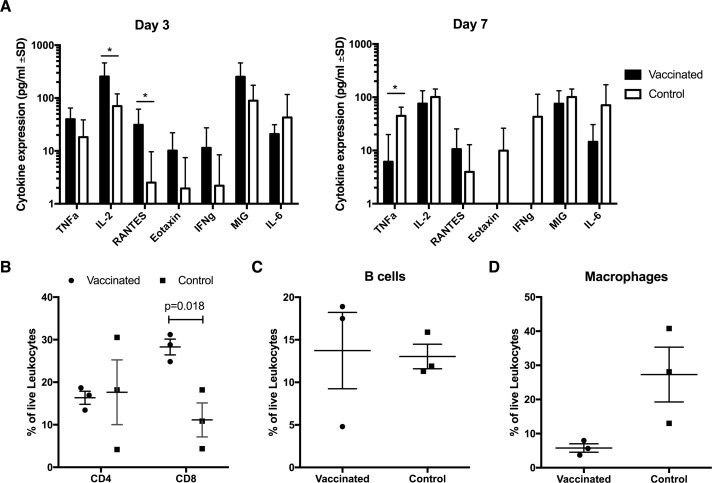
Vaccinated macaques displayed more rapid immune response and less inflammation.A) Inflammatory cytokines were assayed by Bio-Plex using BAL obtained from vaccinated and control macaques on day 3 and day 7 following CA09 challenge (day 3 n = 8 per group, day 7 n = 5 per group). Percentage of B) CD4+ and CD8+ T cells (P = 0.018), C) B cells, and D) macrophages in BAL obtained from vaccinated and control macaques at day 3 post-challenge. *P < 0.05, Mann-Whitney U test. Refer to S2 Fig for a gating scheme of representative samples.